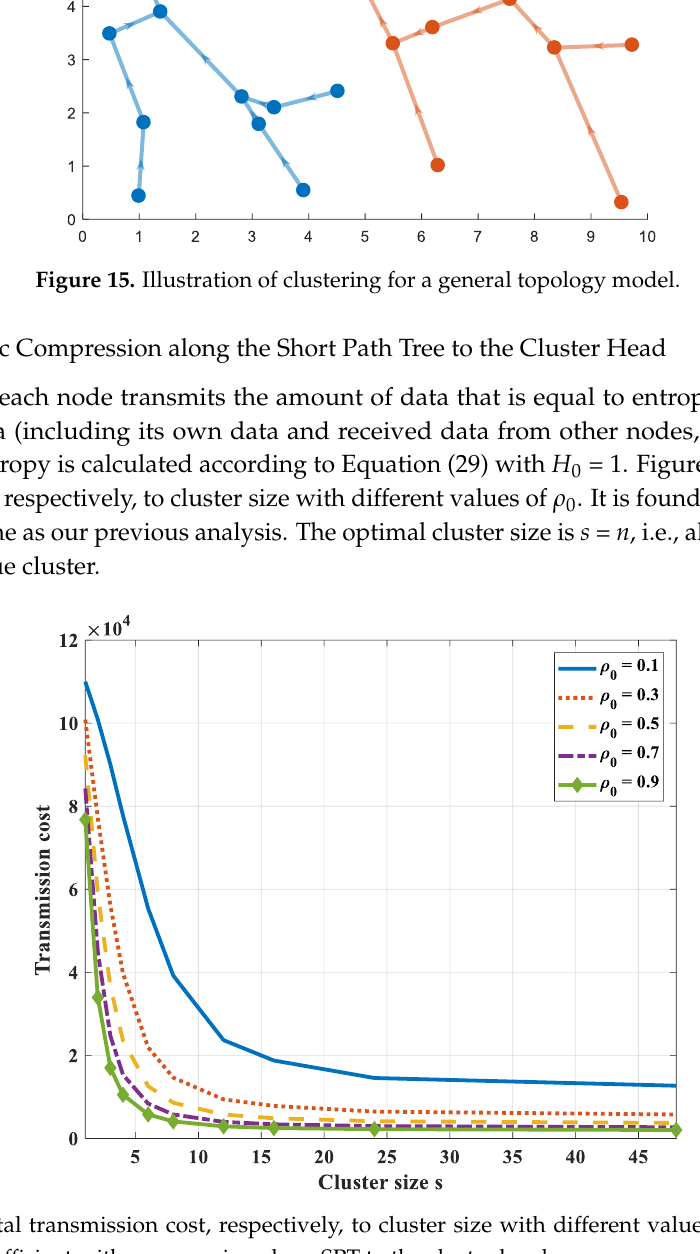
Figure 16. Total transmission cost, respectively, to cluster size with different values of an entropy correlation coefficient with compression along SPT to the cluster head. correlation coefficient with compression along SPT to the cluster